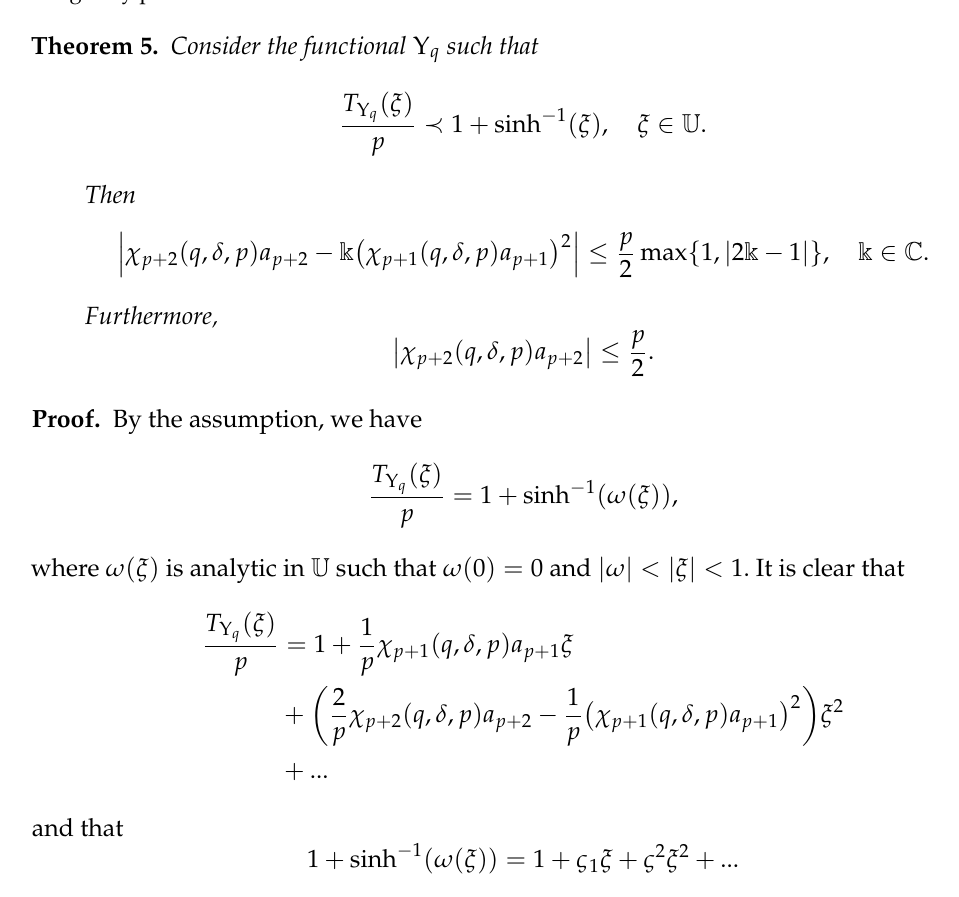
Figure 1. Plotting of the function 1 + sinh − 1 ( ξ ) , which is analytic in the open unit disk and maps it onto the petal-shape domain. The graphs presents the complex map, Riemann surface, real part, and imaginary part of the